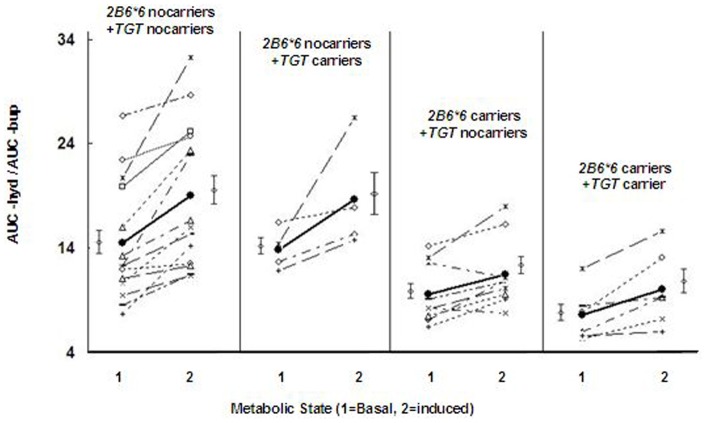
Effects of NR1I2 TGT and CYP2B6*6 on induction of bupropion hydroxylation by SF.Individual profiles showing AUC_hyd/AUC_bup ratios for the basal and SF-induced states in the NR1I2 and CYP2B6 genotype groups (n = 33).